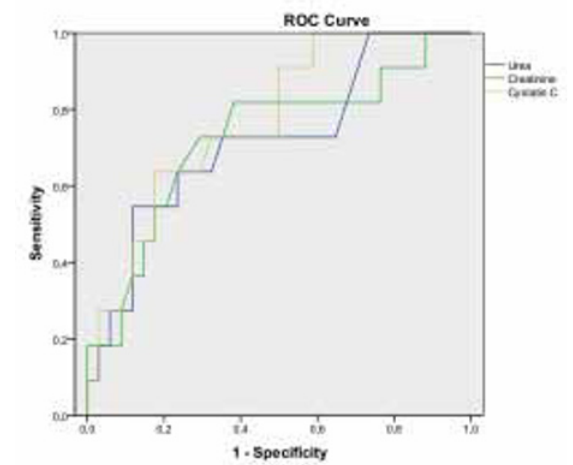
Figure1. Receiver operator characteristic (ROC) curves of BUN (AUC-0.719;95% CI, 0.539-0.899), serum Cr (AUC- 0.726,95% CI, 0.541-0.911) and CysC (AUC-0.770;95% CI, 0.620-0.920, p=0.008) for CysC for predicting one-year